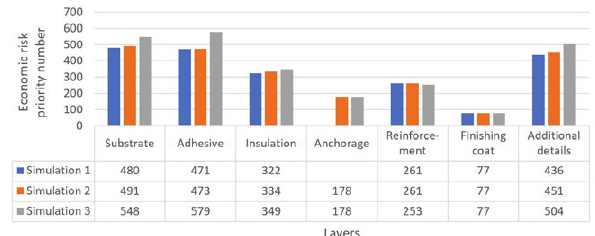
Figure 8. The average ERPN values by layer